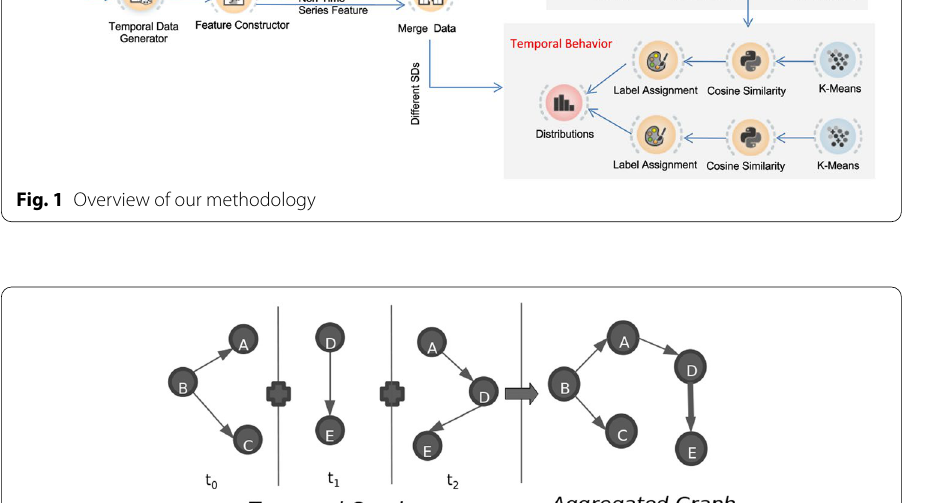
Fig. 2 Sample blockchain temporal graphs and corresponding aggregated